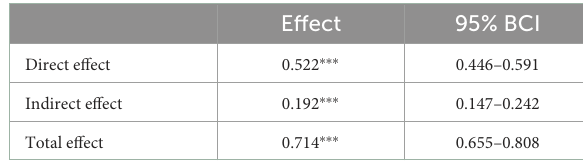
TABLE 2 The mediating effect of self-efficacy on health literacy and health